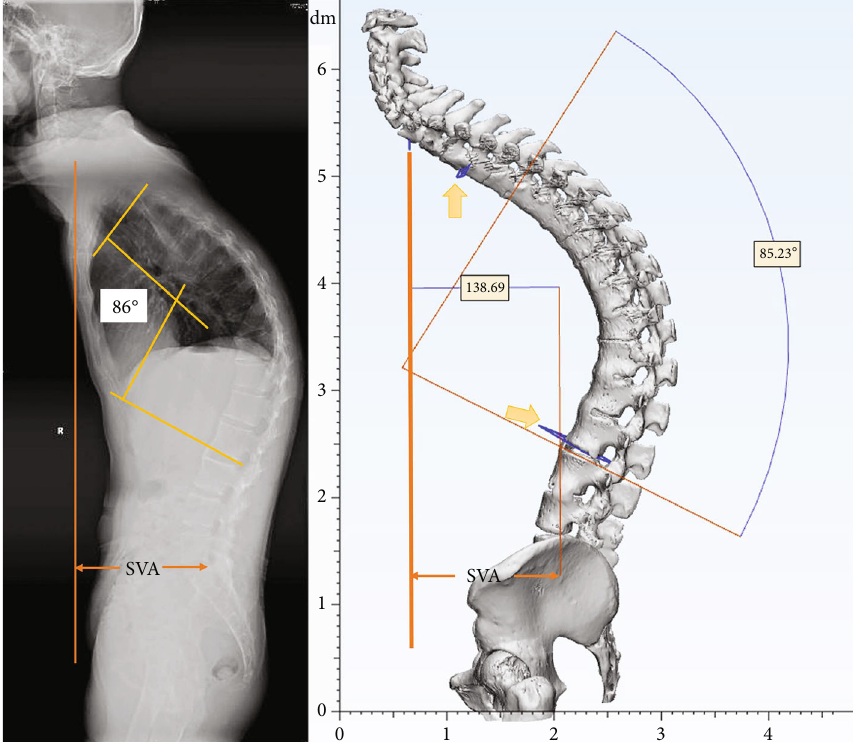
Figure 2: Measurements in Pre-OS. Yellow arrows indicated that planes paralleling to the end plates were used for Cobb angle